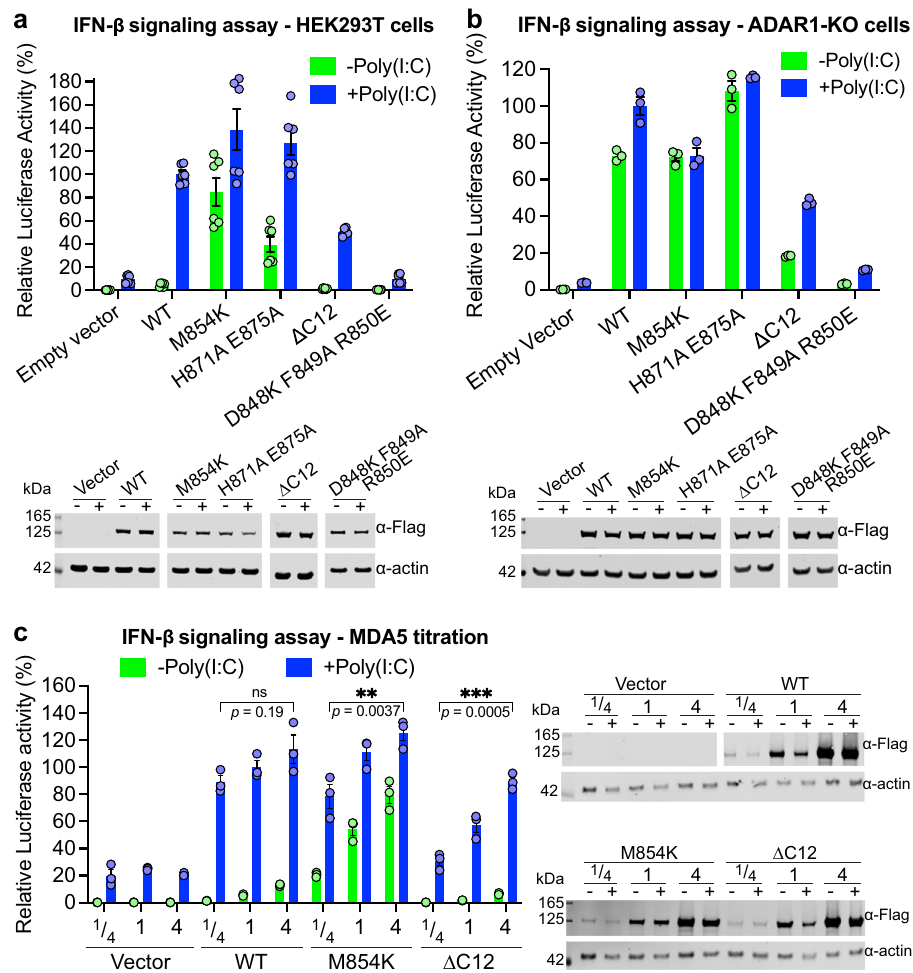
Fig. 1 MDA5 M854K is constitutively active in a cell-based IFN- β reporter assay. a IFN- β reporter signaling assay in HEK cells. Luciferase activity is normalized against WT MDA5 + Poly(I:C) as 100%. n = 6 distinct samples. Lower panel: Western blots showing the expression level of the human MDA5 mutants in HEK cells. The FLAG tag on each mutant was detected with an anti-FLAG antibody. “ − ” , without Poly(I:C) induction; “ + ” , with Poly(I:C) induction. b IFN- β reporter assay in ADAR1-KO HEK cells. Lower panel: Western blots showing the expression level of the human MDA5 mutants in ADAR1-KO cells. n = 3 distinct samples. c IFN- β reporter assay with titration of protein expression level in HEK cells. ¼, 1, and 4 indicate the fold of plasmids transfected. ns, P > 0.05; **, P < 0.01; *** P < 10 − 3 ( n = 3 distinct samples, ordinary one-way ANOVA). WT MDA5 shows a switch-like “ On-Off ” activation mode for signaling. The mutants show signal activation proportional to their expression level, at low dsRNA abundance without poly(I:C). Lower panel: Western blots showing the expression level of the human MDA5 mutants in titration experiments. All error bars in this fi gure represent SEM between measurements, centered on the mean. Source data are provided as a Source Data fi le. All cell-based assays were repeated independently at least three times with similar